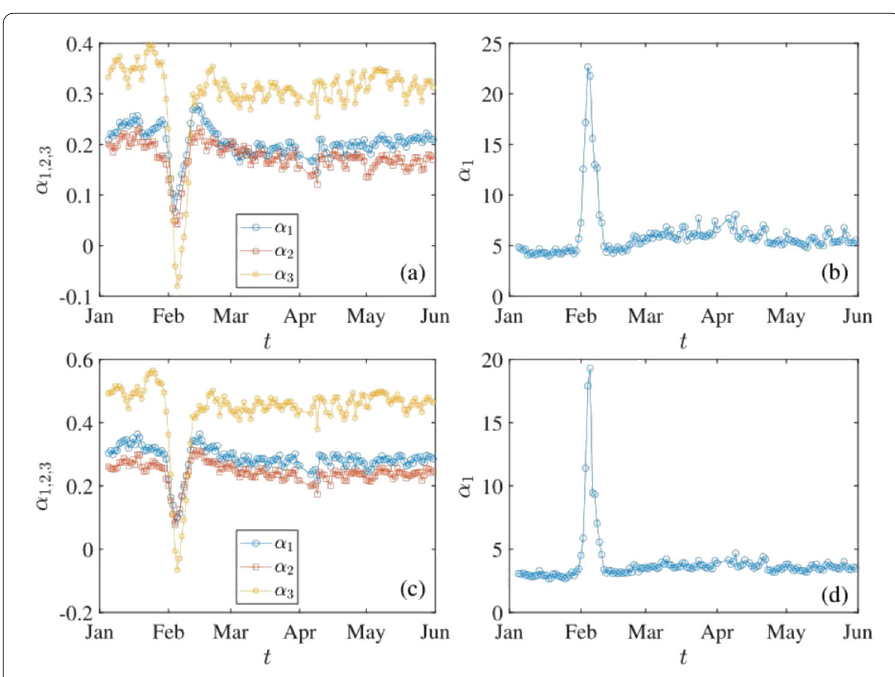
Figure 15 Evolution of the exponents of daily directed and undirected freight highway transportation networks. ( a ) Scatter data of F ij with respect to G α 1 with respect to G α 1 i G α 2 j / d α 3 ij for the directed network. ( c ) Scatter data of W ij with respect to G α 1 i G α 2 j / d α 3 ij for the undirected network. ( d ) Binning data of W ij with respect to G α 1 i G α 2 j / d α 3 ij for the undirected